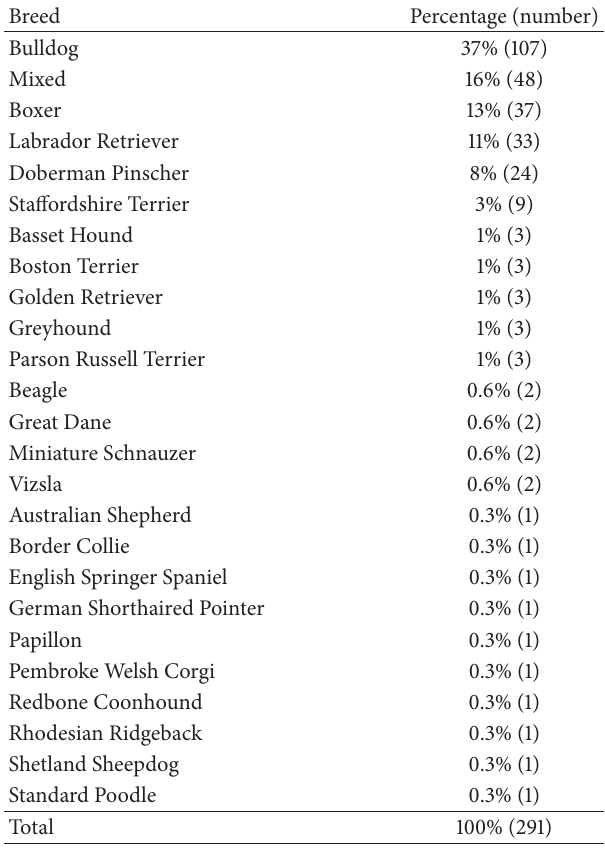
Table 1: Breed distribution of 291 dogs with